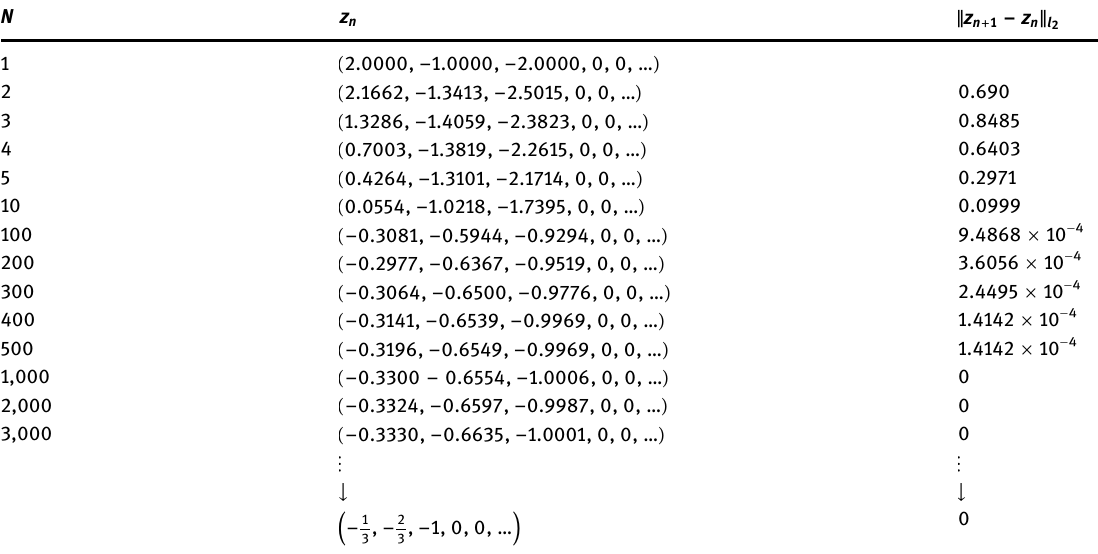
Table 1: Convergence of the fi rst component { } z n of { } u n generated by ( 62